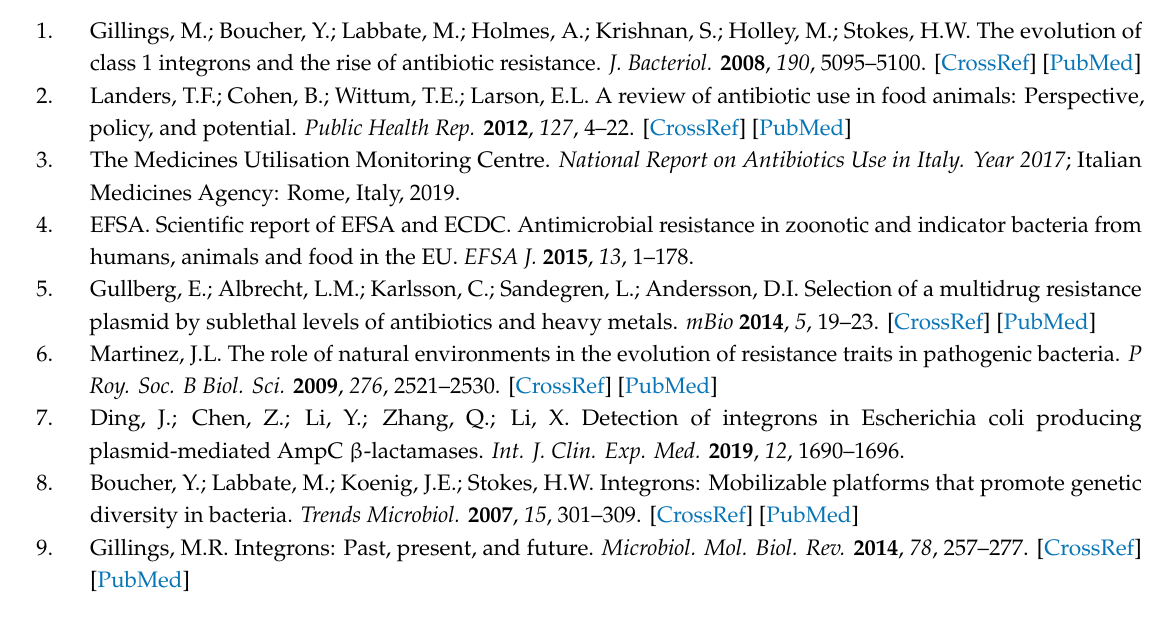
Figure S1: GIS map (1:900.000) of sampling sites (1-2: Mori / AGR1-MO, 3: Rovereto / RO, 4: Trento / TRE, 5: Mezzolombardo / AGR2, 6: Ora-auer / AGR3, 7: Bolzano / BO, 8: Caldaro-Kaltern / CA, 9-10: Sporminore / ME1-ME2, 11-12: Ora-auer / ME3-ME4, 13: Monticolo-Montiggl / MON1-MON2, 14: Val di Mazia-Matschertal / VAL) in Trentino-Alto Adige region; Table S1: main articles related to the dissemination of intl1 into non-clinical open environments. Table S2: Intl1 PCR amplification results from samples collected from sediments within vineyard and apple orchard agricultural sites; Table S3: Intl1 PCR amplification results from samples collected from grass rhizosphere, tree rhizosphere and root-free soil within vineyard and apple orchard agricultural sites; Table S4: Intl1 PCR amplification results from samples collected from stream or river sediments within urban sites; Table S5: Intl1 PCR amplification results from samples collected from soil and litter within the Monticolo-Montiggl forest site; Table S6: Intl1 PCR amplification results from samples collected in mineral soils from Val di Mazia-Matschertal glacier